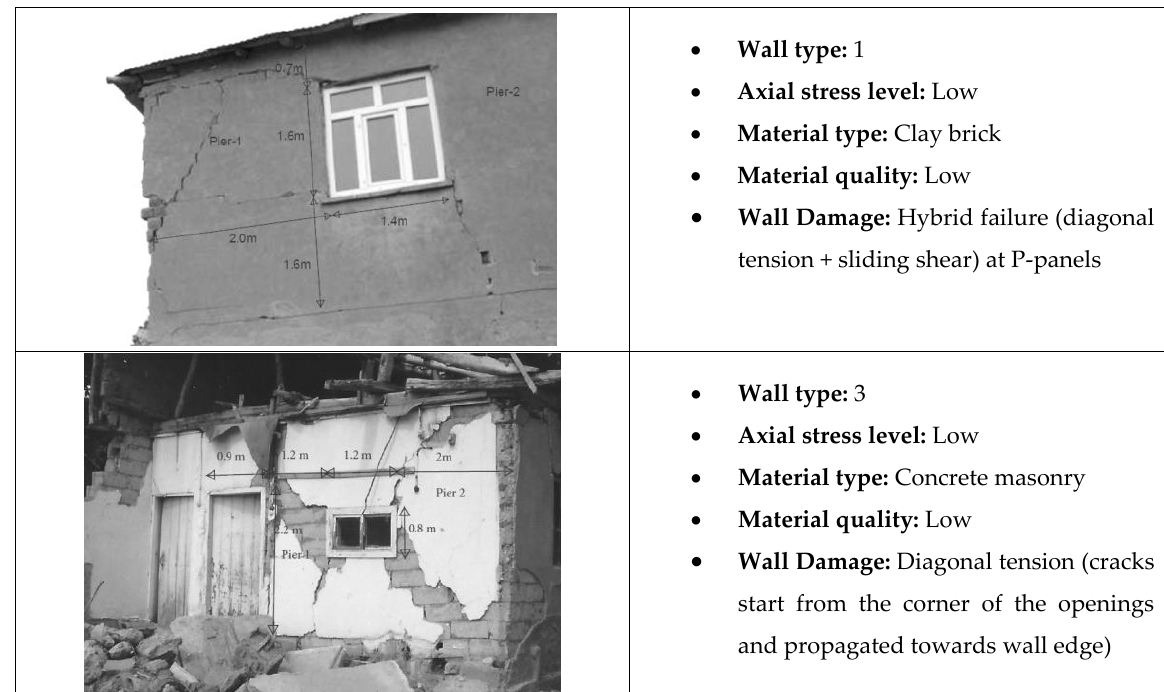
Figure 5. Examples of the collected data regarding post-earthquake URM damage observations during the 1995 Dinar Turkey earthquake [11] and the 2011 Van Turkey earthquake [15].